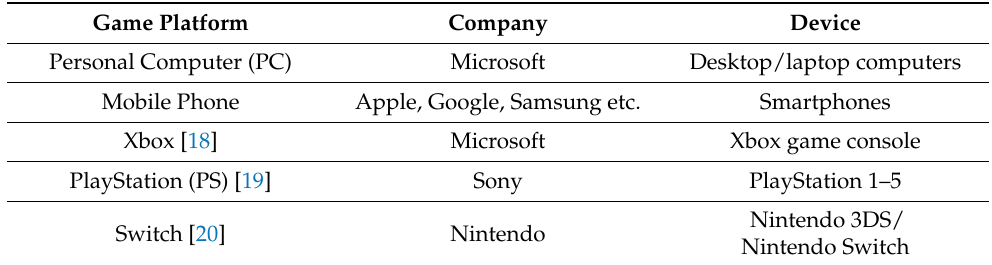
Table 1. Mainstream game platforms and corresponding compatible device in the 21st century. Game